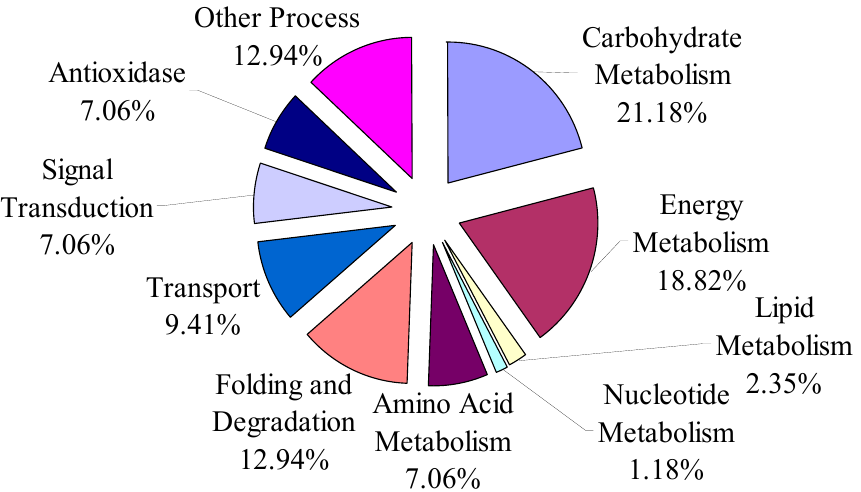
Figure 3. Functional classification and the proportion of 68 significantly differential proteins identified in the cotton stem barks’ induced changes by chilling stress and grafting.